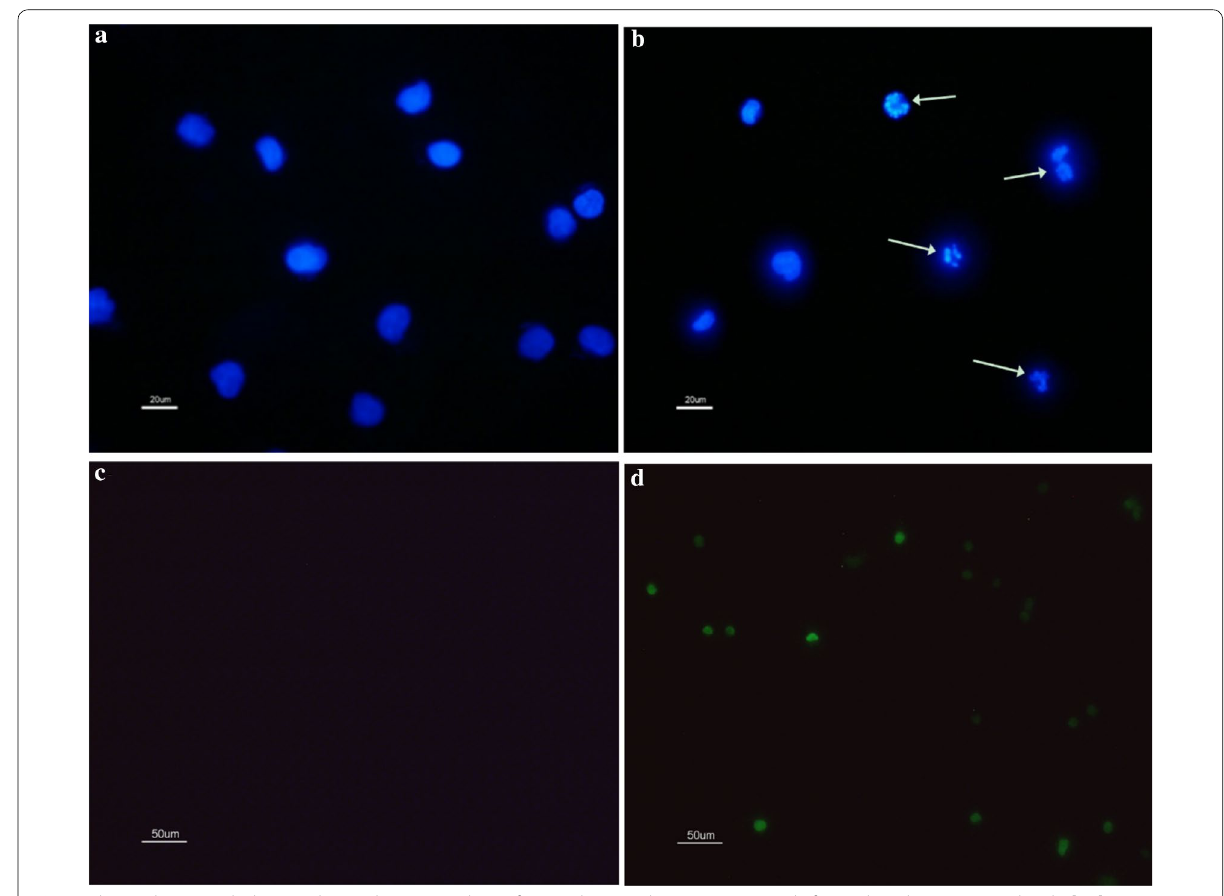
Fig. 4 The nuclear morphology and DNA damage analysis of K562. The samples were measured after 48 h without ( a , c ) and with ( b , d ) treatment of 65.76 μM lipopeptides. a , b The white arrows indicate the condensed chromatin; The scale bar is 20 μm. c , d The green fluorescence indicates that the cell is apoptotic, and the intracellular DNase is activated to cut off the damaged DNA; The scale bar is 50